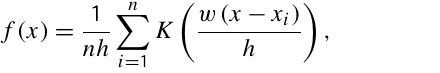
and May, respectively.